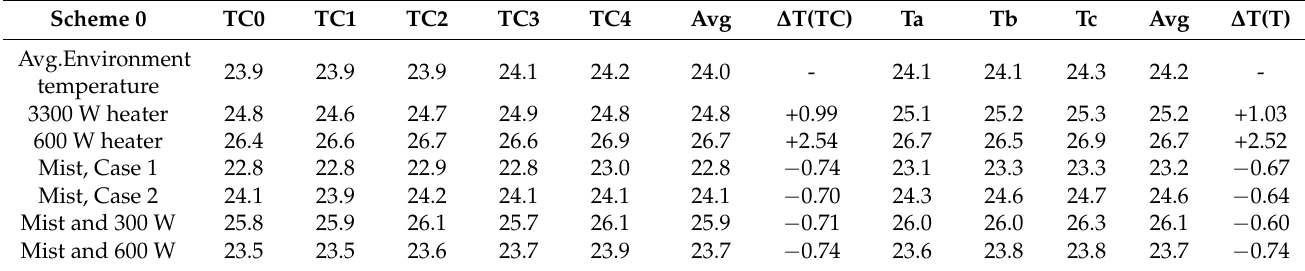
Table 3. Measurements of misting fan and heater temperature changes (in K) of thermocouples (TC) and thermistors